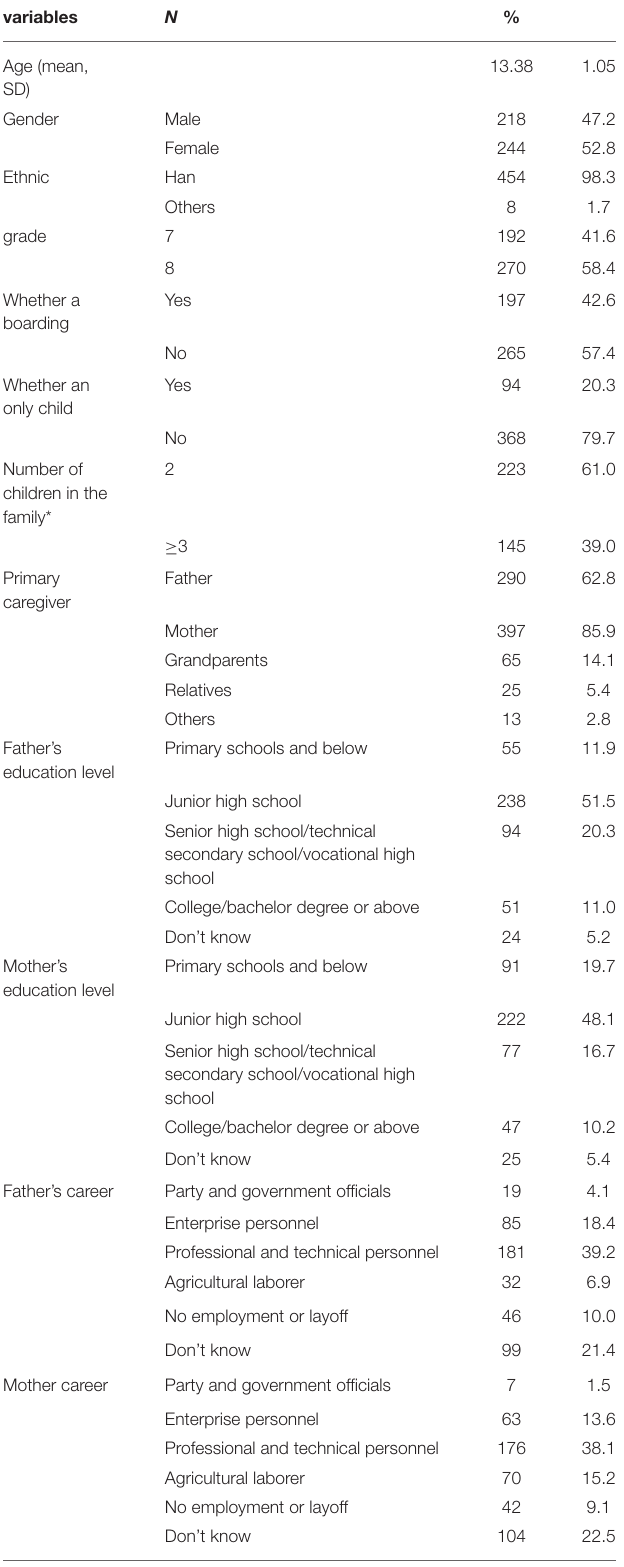
TABLE 1 | Basic demographic